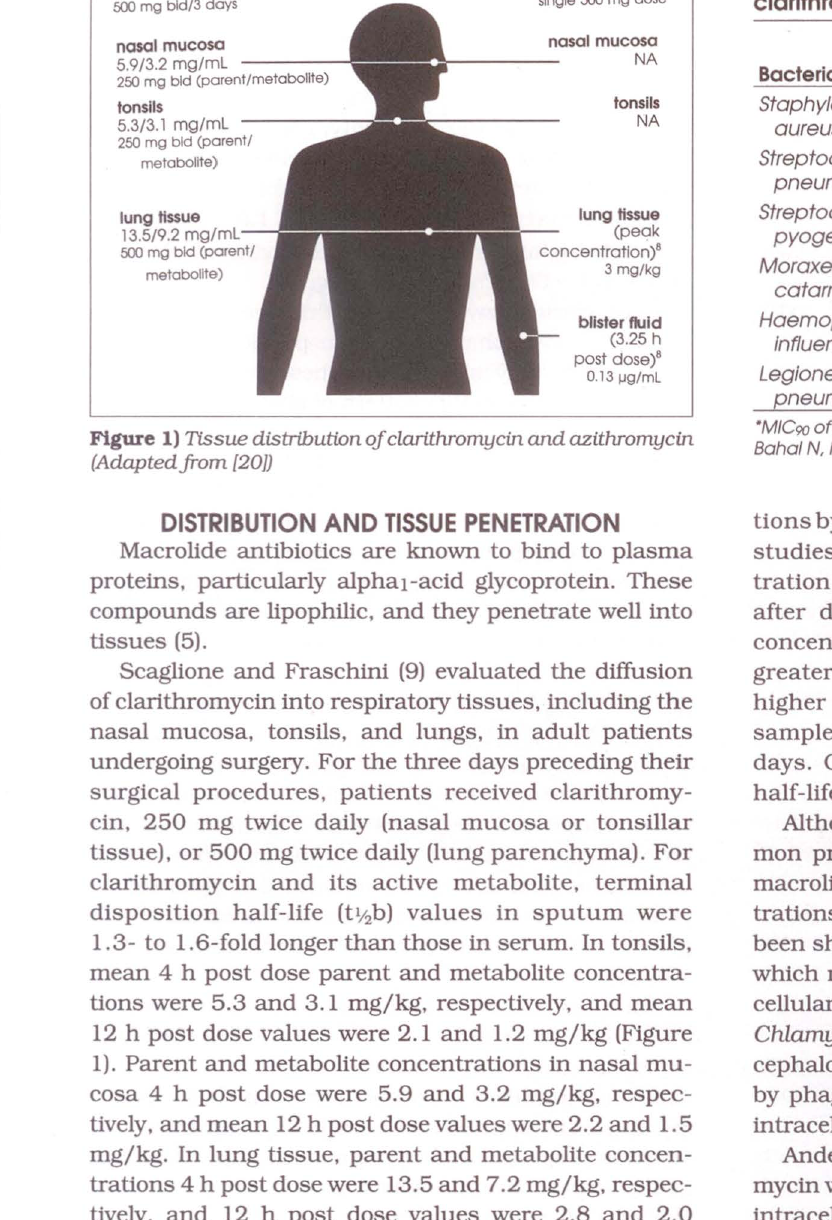
In vitro MIC90 values of erythromycin, azithromycin